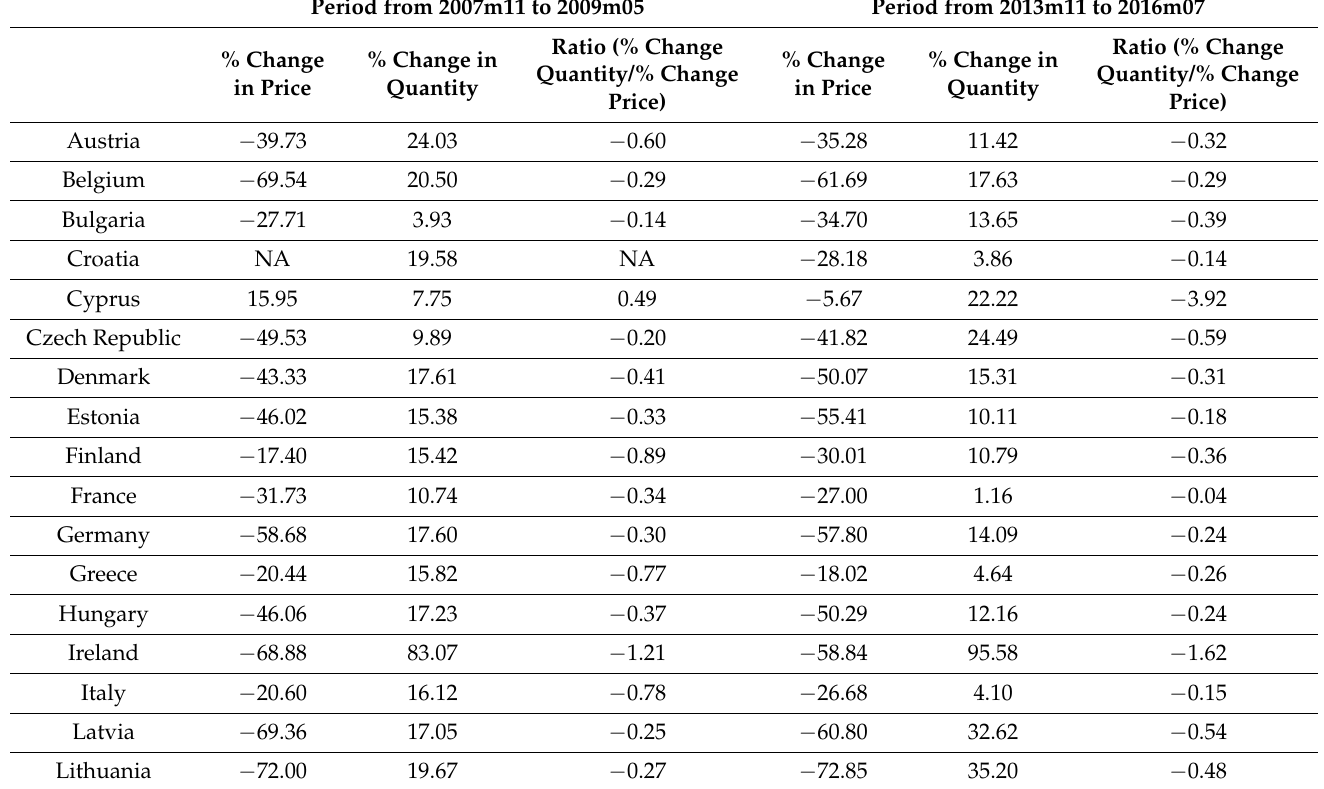
Table 1. Comparison price and quantity reactions of milk